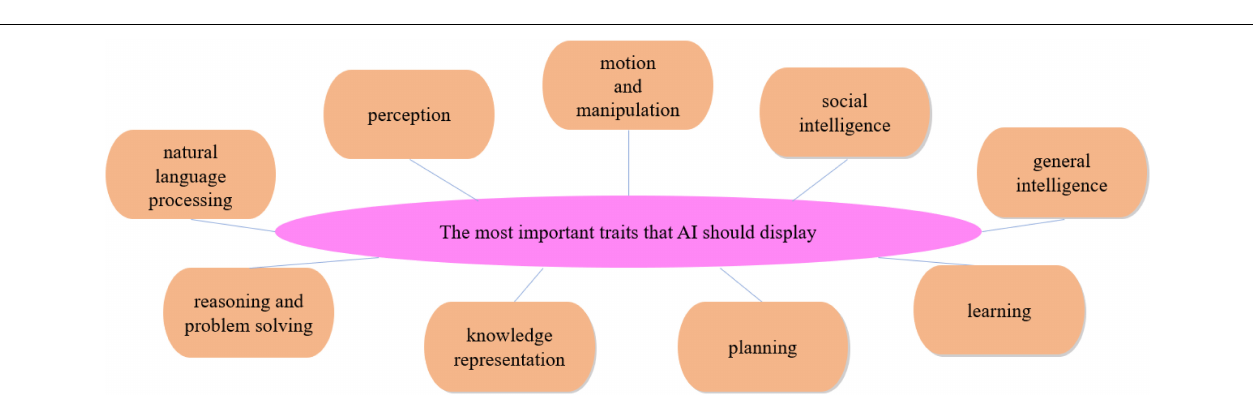
FIGURE 1 | Evolution of the research workflow in computational chemistry from Butler et al. (2018).